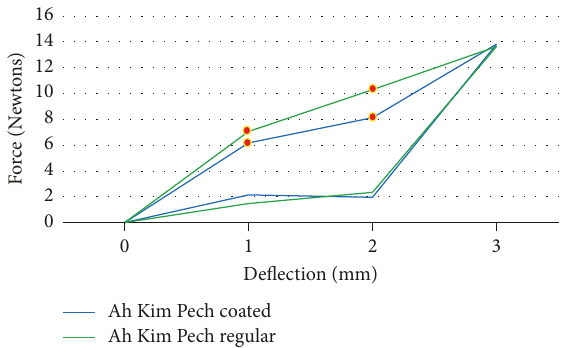
Figure7:Comparisonofmeanforce(N)loadandunloaddeflection between the coated and regular rectangular Ah Kim Pech 0.016 󸀠󸀠 × 0.022 󸀠󸀠 Ni-Ti wires. There was a statistically significant decrease in the coated Ni-Ti wires at 1mm ( 𝑝 < 0.01 ) and 2 mm ( 𝑝 < 0.01 ) load deflection compared with the regular Ni-Ti wire. There was no statistically significant difference in the unload deflection.